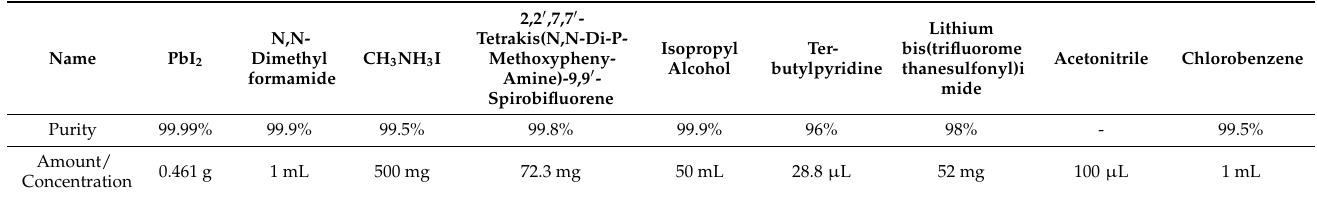
Table 1. The list of main materials used in this